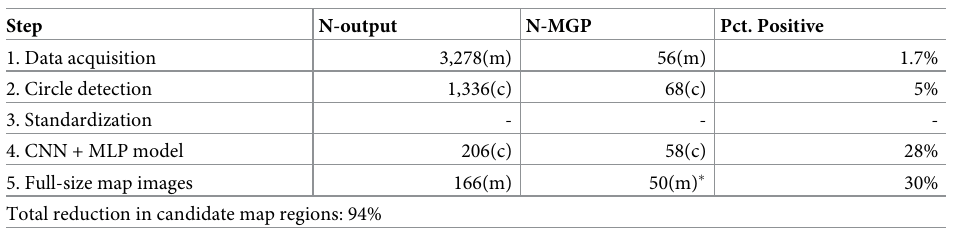
Table 4. Step-wise reduction in candidate map